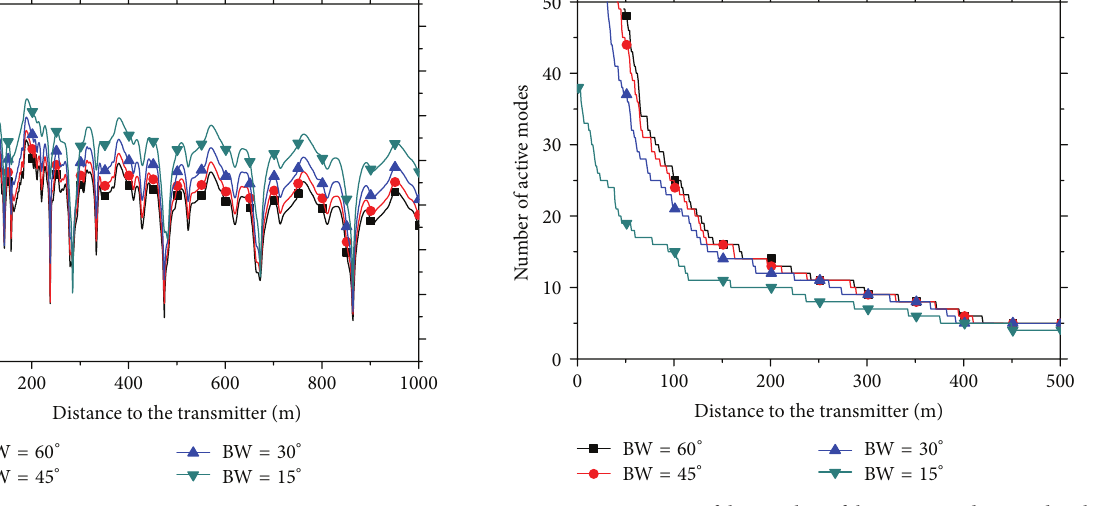
Figure 5: Variations of received powers along the tunnel axis for different antenna beam widths located in the centre of the cross section of tunnel, in which the azimuth and elevation angles of the antenna beam are 0 ∘ .